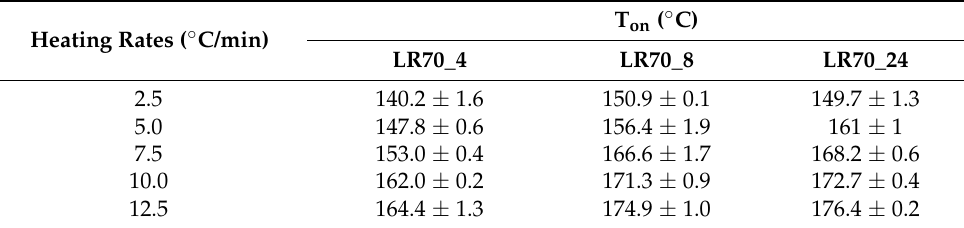
Table 4. Parameters T on obtained for five rates of heating sample during the thermo-oxidative processes of interesterified fats.